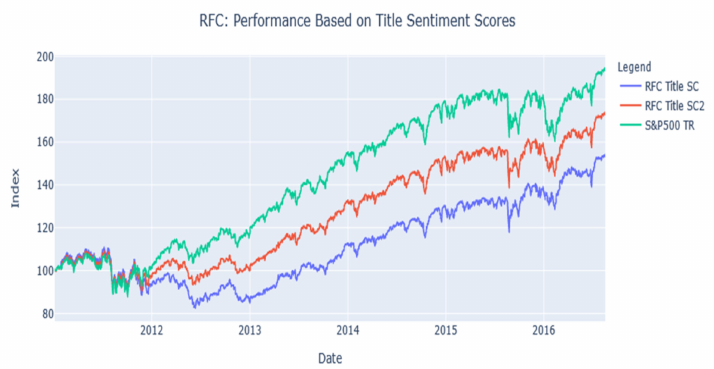
Figure 9. Out-of-sample performance of random forest classification based on title sentiment scores.